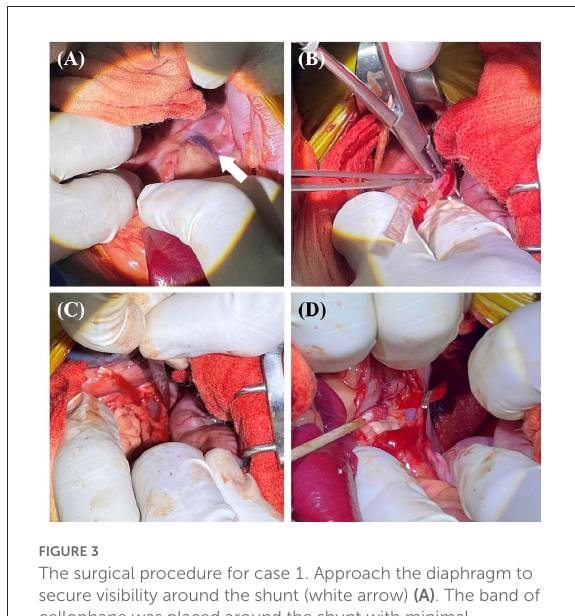
FIGURE3 The surgical procedure for case 1. Approach the diaphragm to secure visibility around the shunt (white arrow) (A) . The band of cellophane was placed around the shunt with minimal dissection (B,C) . The band was placed in contact with the wall of the shunt without decreasing the diameter of the shunt. Vascular clips were used to secure the band in place (D) .